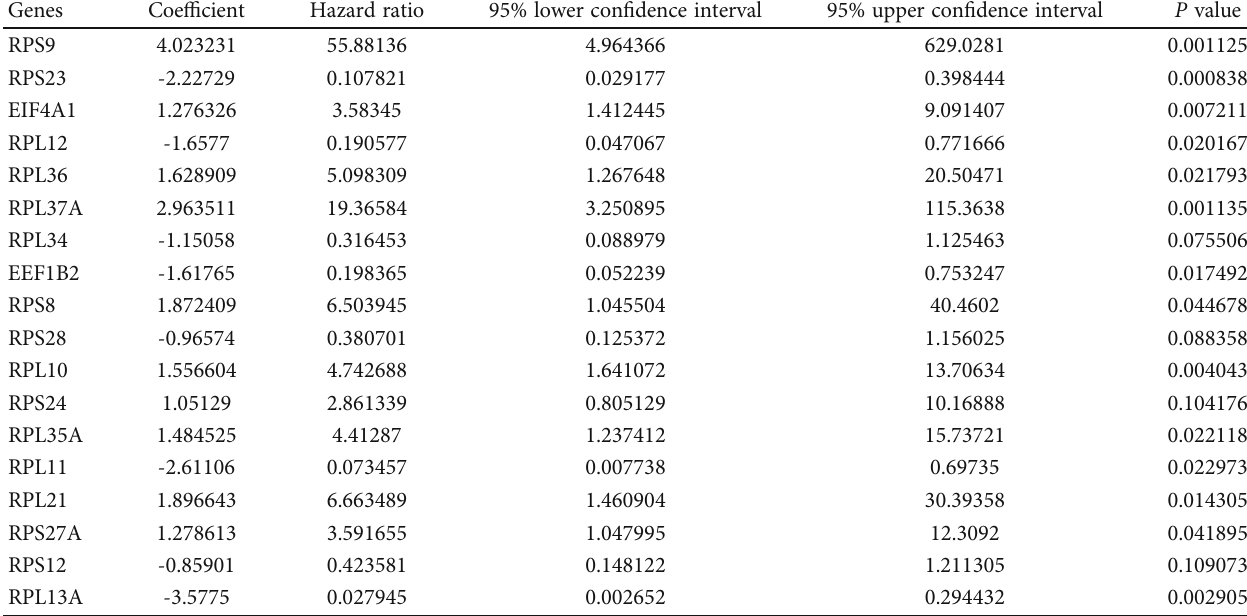
Table 3: Multivariate cox regression models of prognostic EMT-derived genes in the TARGET